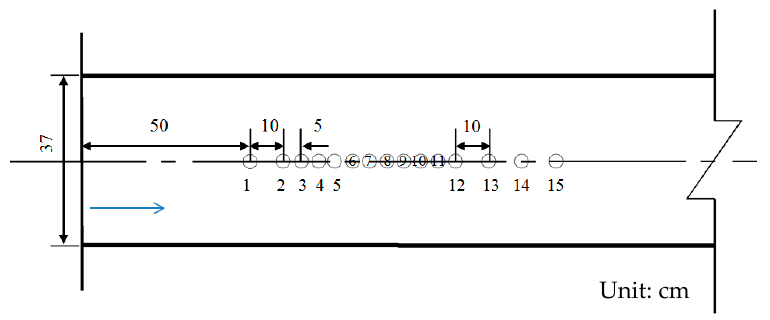
Figure 3. Test point arrangement.